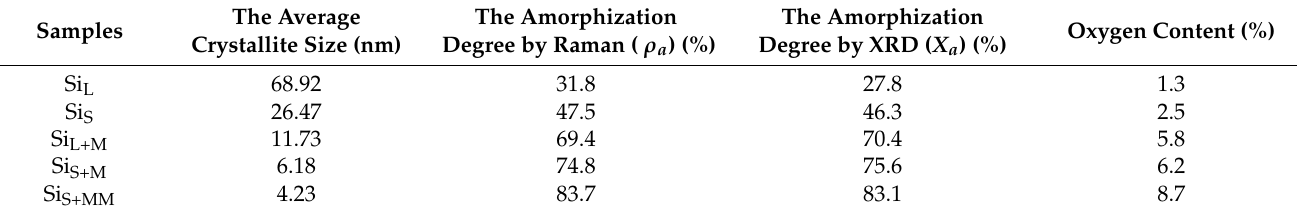
Table 3. The average crystallite size, the amorphization degree and oxygen content of Si L , Si S , Si L+M , Si S+M and Si S+MM . The Average Samples Crystallite Size